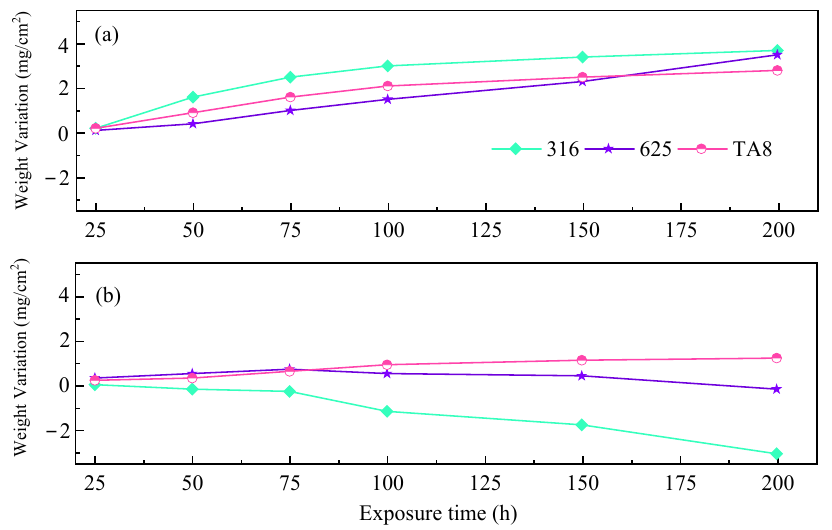
Figure 7. Corrosion weight gain of the tested alloys exposed to SCW at experiments Run-1 to Run-6, respectively; ( a ) the specimens at the top reaction tube; ( b ) the specimens at the bottom reaction tube.